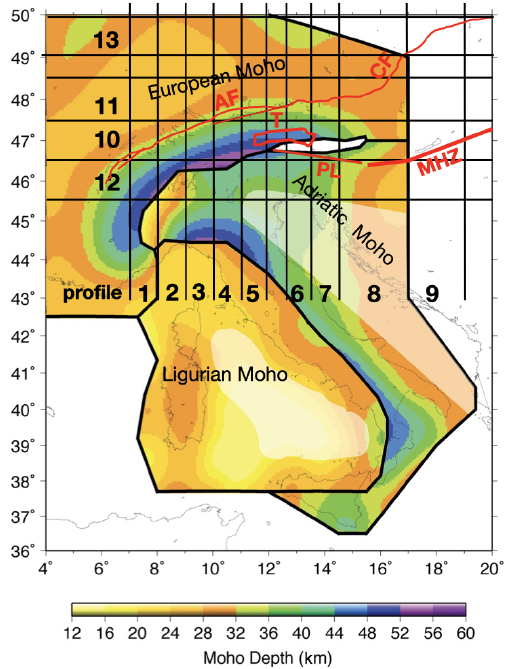
Figure 2. Moho map by Spada et al. (2013) with the locations of the sampling corridors used for profiles 1–13 shown in Figs. 3–14 and 20. The locations of the Mid-Hungarian Fault Zone (MHZ), the Periadriatic Line (PL), the Tauern Window (T), the Alpine Front (AF) and the Carpathians Front (CF) are also marked. The space between two black lines marks the width of the profile